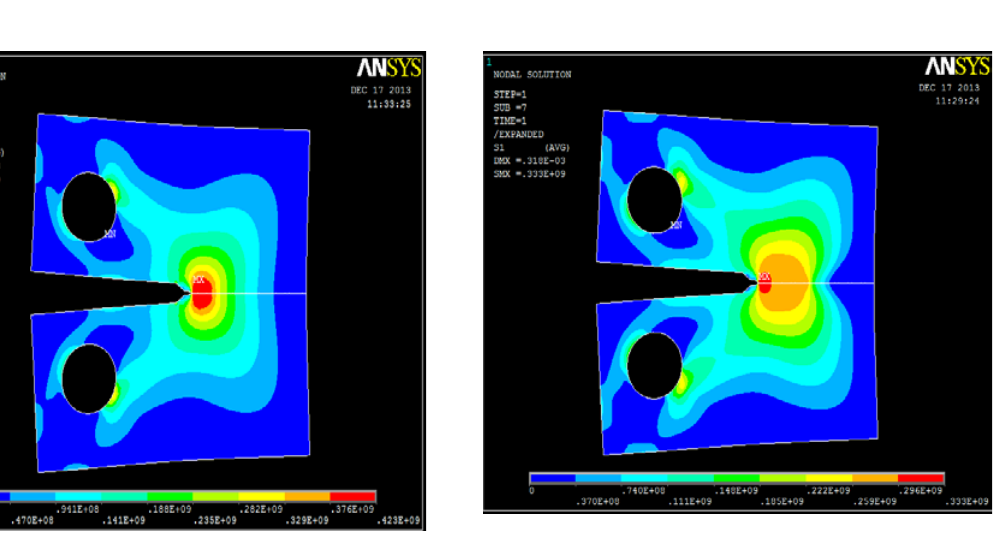
Figure 11: Principal stress distribution in CT specimen for Alloy 276 at 30 o C